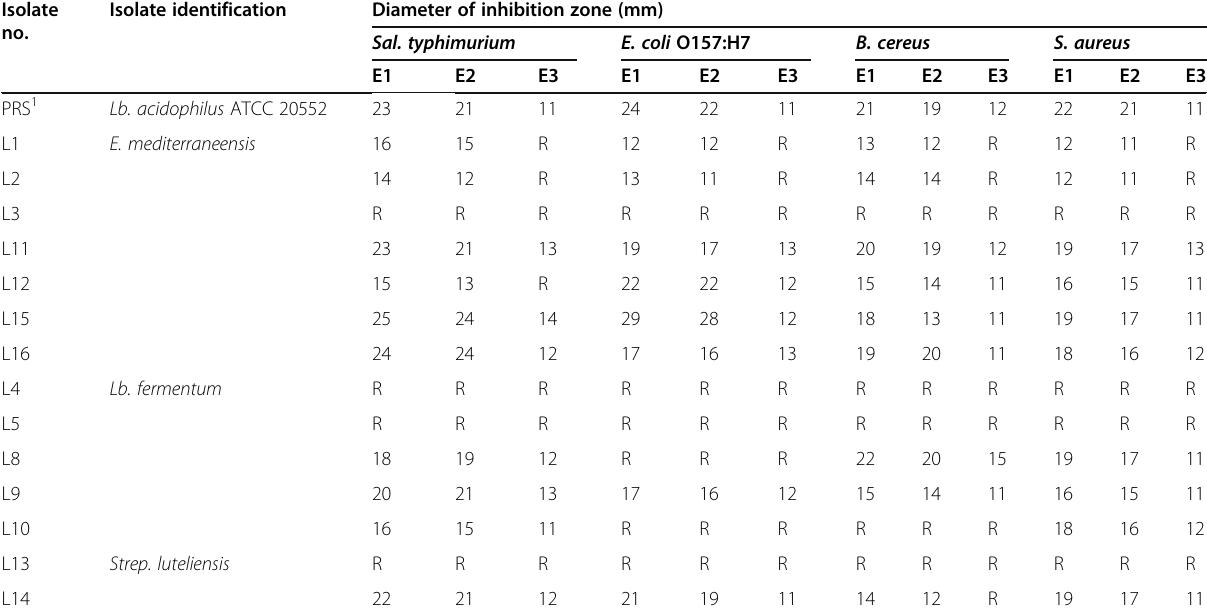
Table 10 Inhibitory effect of the extracts prepared from isolated LAB Isolate